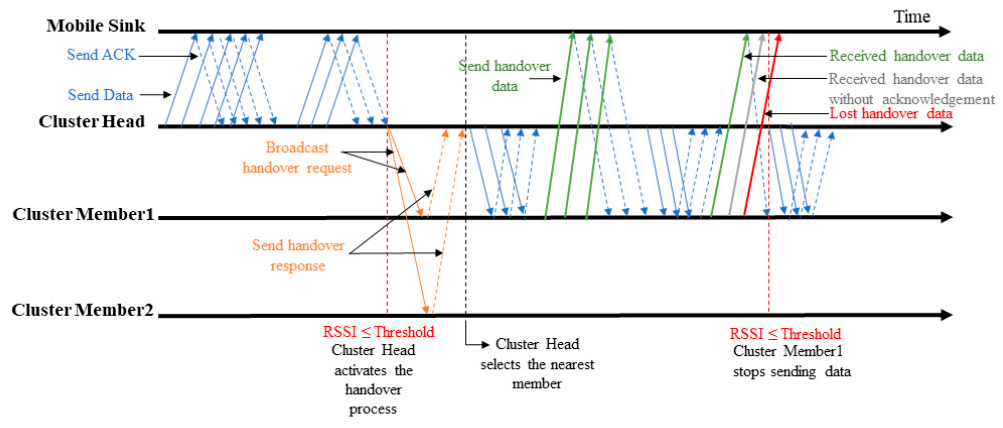
Figure 3. BMAC-H Figure 3. BMAC-H behavior. Algorithm 3: BMAC-H algorithm at CH for Cluster-Based Wireless Sensor Network.